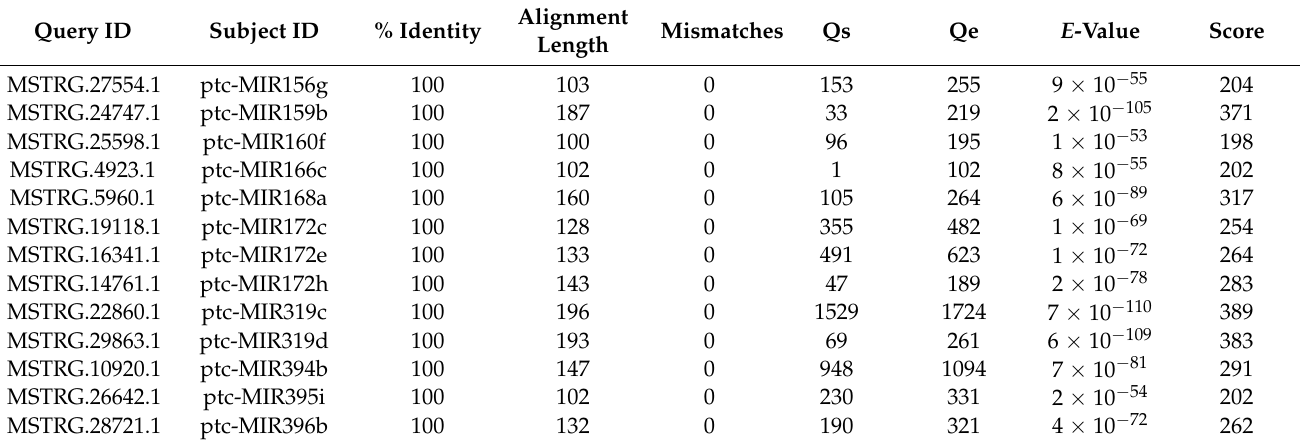
Table 2. LncRNAs Identified as Precursors of Known miRNAs in P. tomentosa